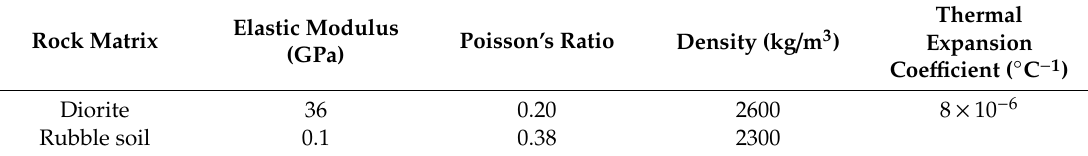
Table 1. The physical parameters of rock masses [30,42].